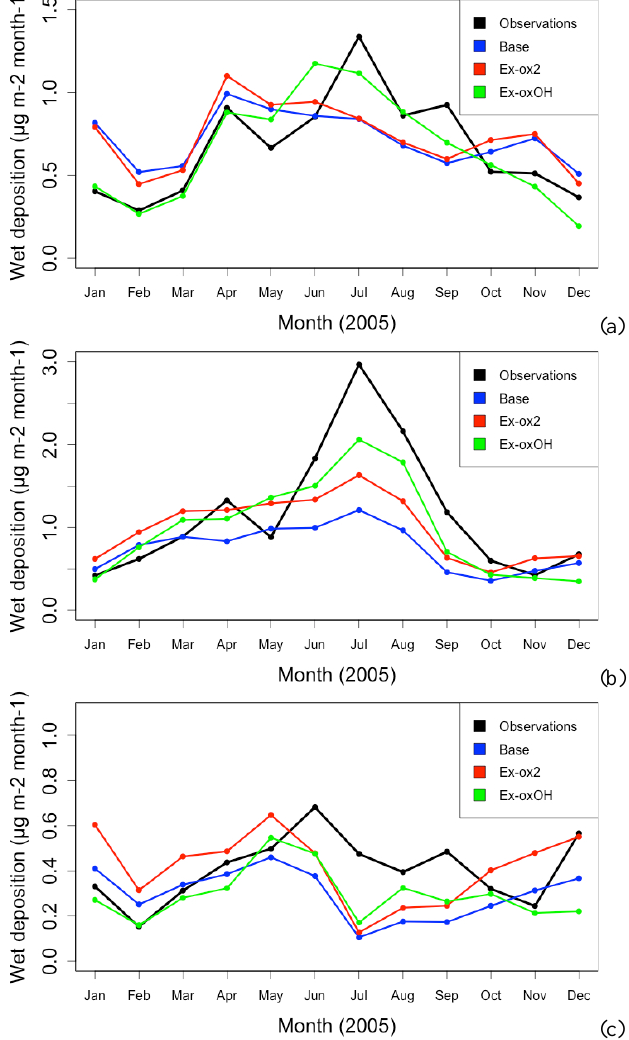
Fig. 8. Comparison of seasonal model estimates with MDN mea- surement data, all monthly means, for continental regions in North America. (a) Northeast (49 sites) and (b) southeast (24 sites) are divided by 36 ◦ N. (c) The western region represents 15 sites from 100 ◦ W. Stations are mapped in Fig. 1, and a detailed list is given in Appendix Table